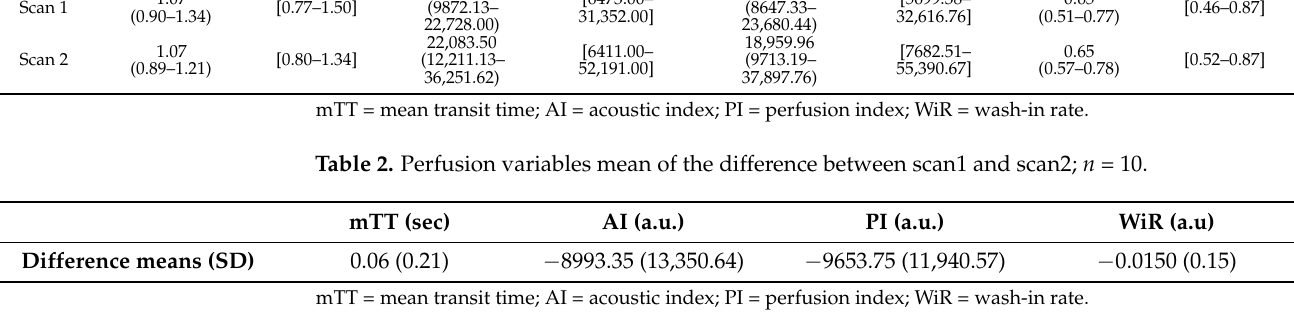
Table 3. Patients’ cardiovascular measures on CEUS sessions; n =